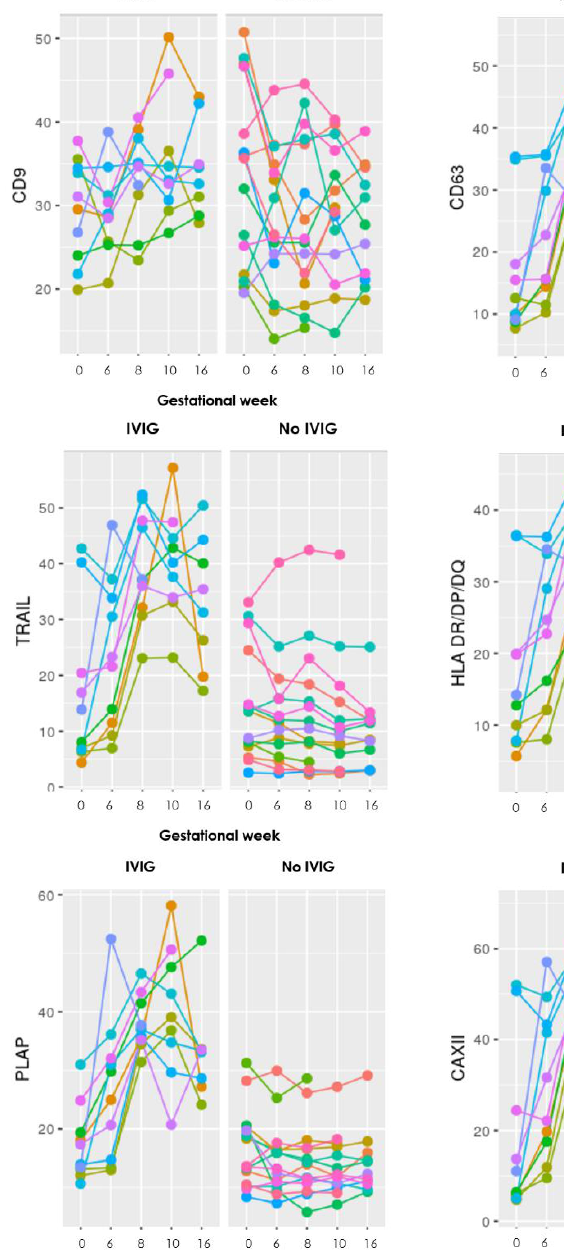
Table 4. Mean difference of IVIG in changes in progression of sEV levels measured at baseline (S1) to sixth gestational week (S2).